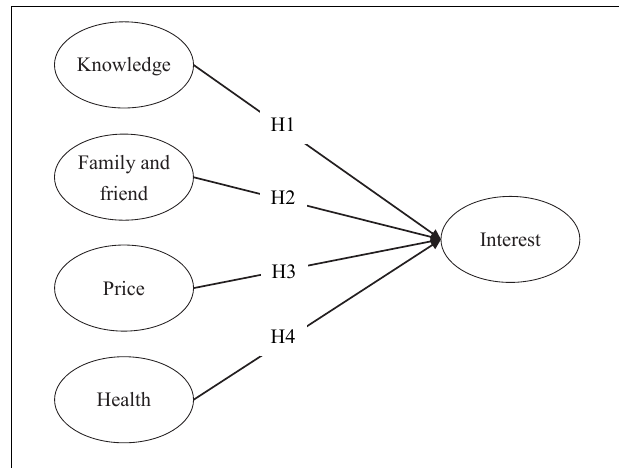
FIGURE 1 | Research